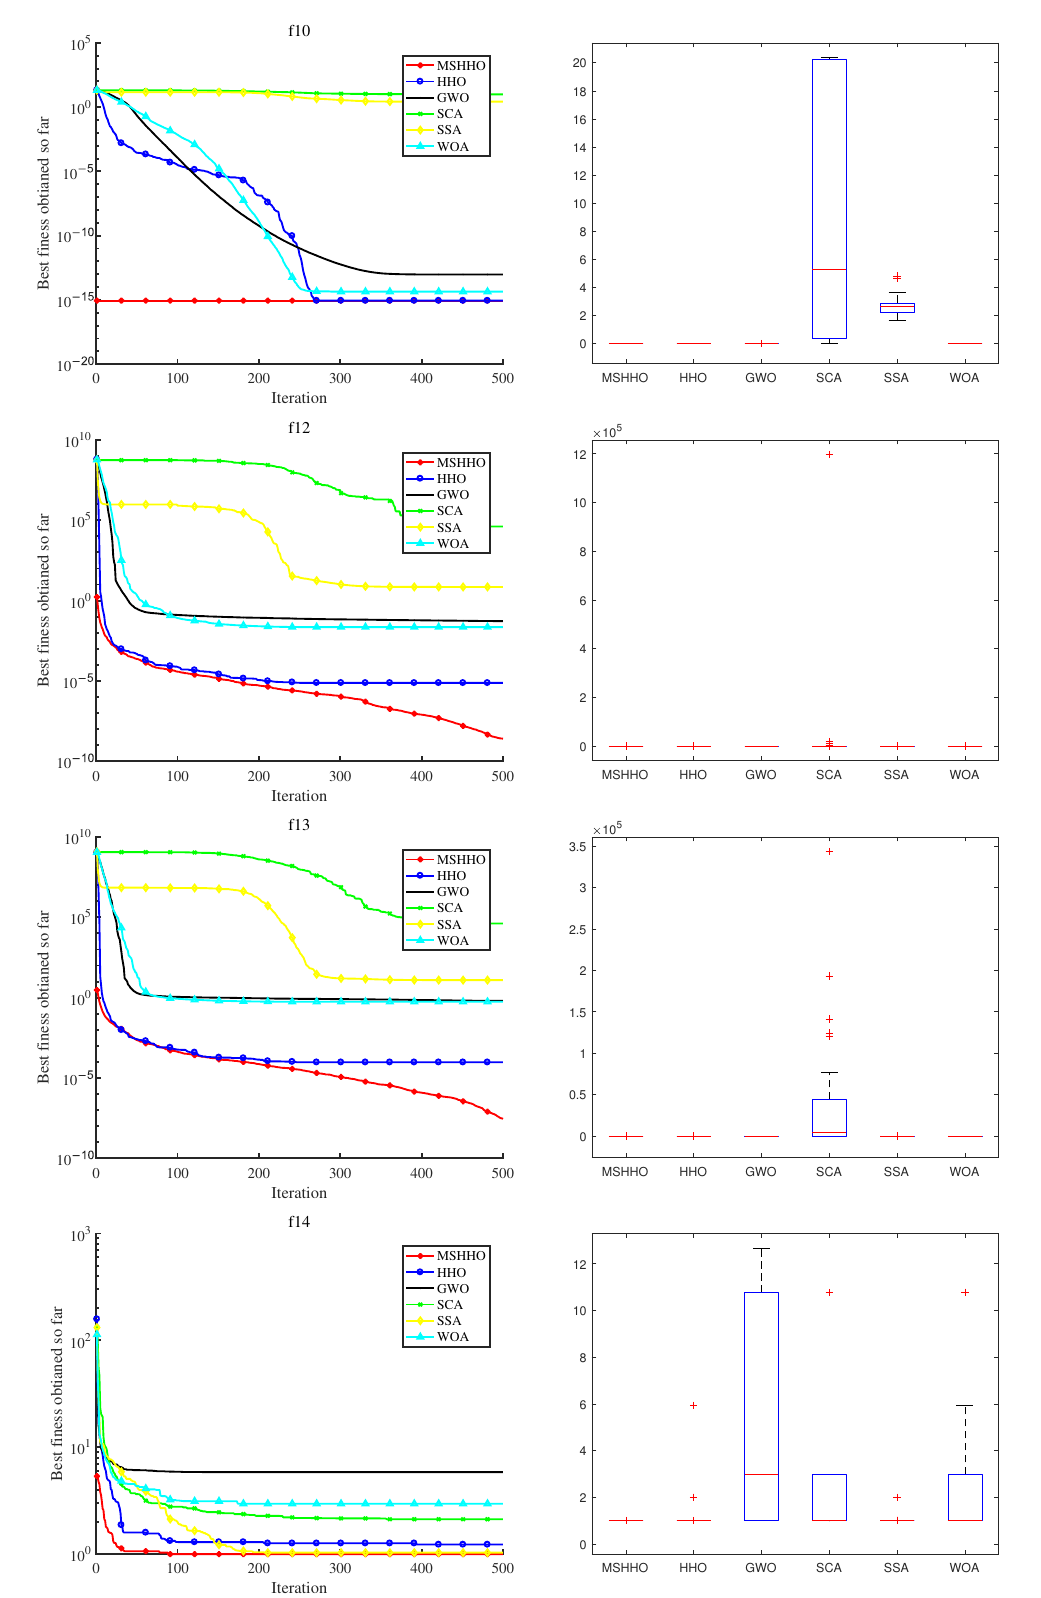
Figure 7. Qualitative results of F10, F12, F13, and F14